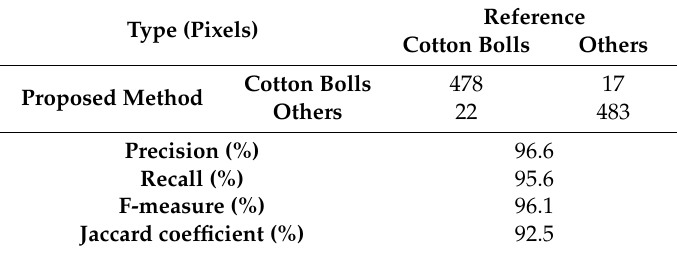
Table 4. Cotton boll extraction accuracy in the south